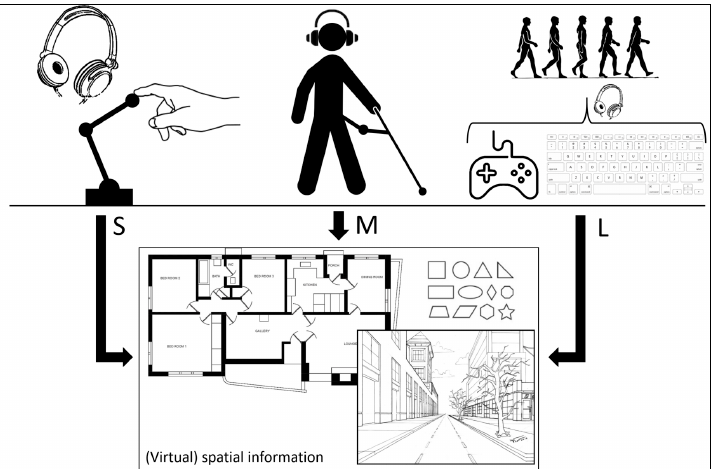
Figure 4. Common examples for small, medium and large walkable and touchable VR applications following [40,54,57]. From left to right: Exocentric exploration with grounded force feedback, egocentric exploration with a virtual white cane in a tracked environment or by controlling an avatar with the keyboard or a game controller. The haptic exploration process of spatial information is in each case supplemented by audio feedback; as examples for spatial information, a floor plan, an outdoor scene or simple geometric shapes are shown.